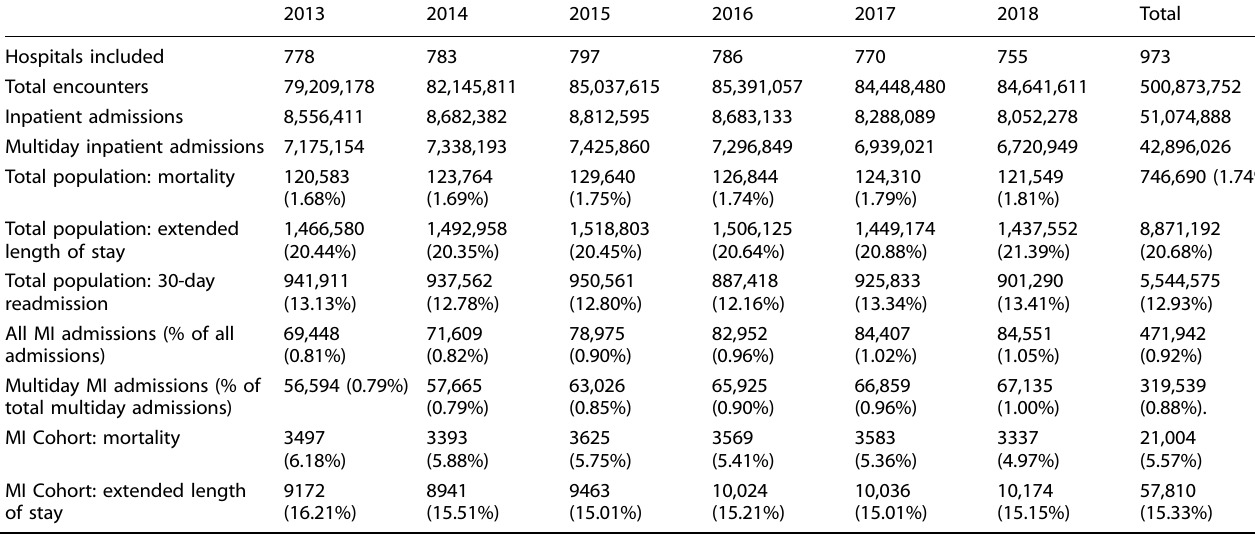
Table 2. Population information for data included for risk strati fi cation using machine